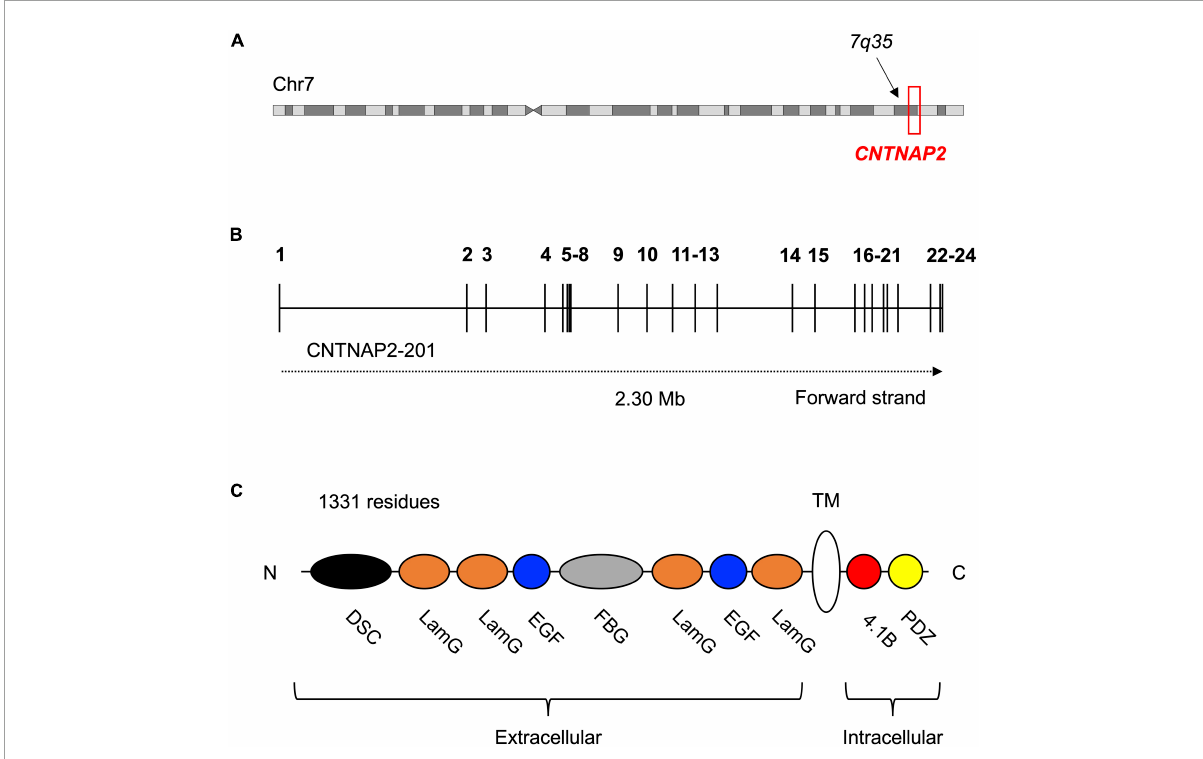
FIGURE1 Location and structure of the contactin-associated protein-like 2 ( CNTNAP2 ) gene and protein. (A) Contactin-associated protein-like 2 is located at the distal end of the long arm (q) of chromosome 7 (GRCh38 chr7: 146,116,002–148,420,998). (B) Schematic of the 24 exons (numbered) and 23 introns of the CNTNAP2 gene. Transcript CNTNAP2-201 is the canonical transcript. (C) Structure of the contactin-associated protein-like 2 (CASPR2) protein and its eight extracellular, one transmembrane, and two intracellular subdomains.